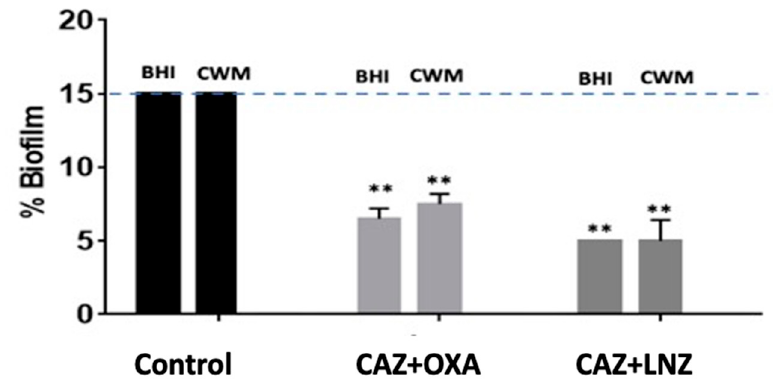
Figure 8. Percentage of biofilm reduction on preformed Staphylococcus aureus Newman and Pseu- domonas aeruginosa PAO1 mixed biofilm in the BioFlux TM system using 10x MIC of ceftazidime (CAZ) + oxacillin (OXA) and 10x MIC of ceftazidime (CAZ) + linezolid (LNZ) in the CWM and BHI media. An automatized debridement was fixed at 15% of biofilm left in the microfluidic channel. Samples were tested in three independent experiments. Results are presented as the mean ± stan- dard deviation. Statistics were performed using a t -test on GraphPad Prism version 7. Ns, p > 0.05; ** p <